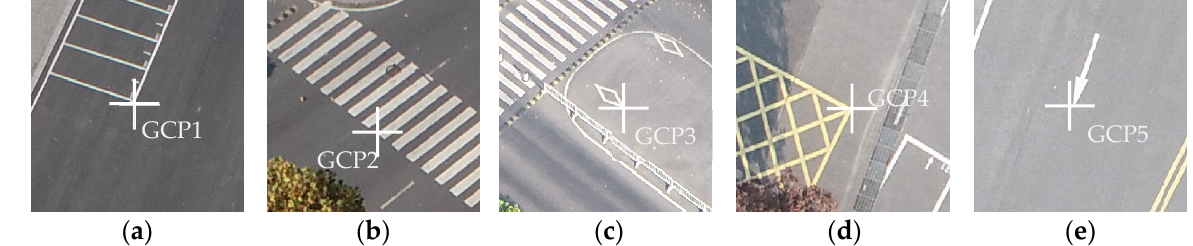
Figure 5. Five different types of road traffic signs and the ground control points on them (GCP1~GCP5): ( a ) hollow rectangle; ( b ) solid rectangle; ( c ) hollow diamond; ( d ) grid rectangle; ( e ) solid arrow.